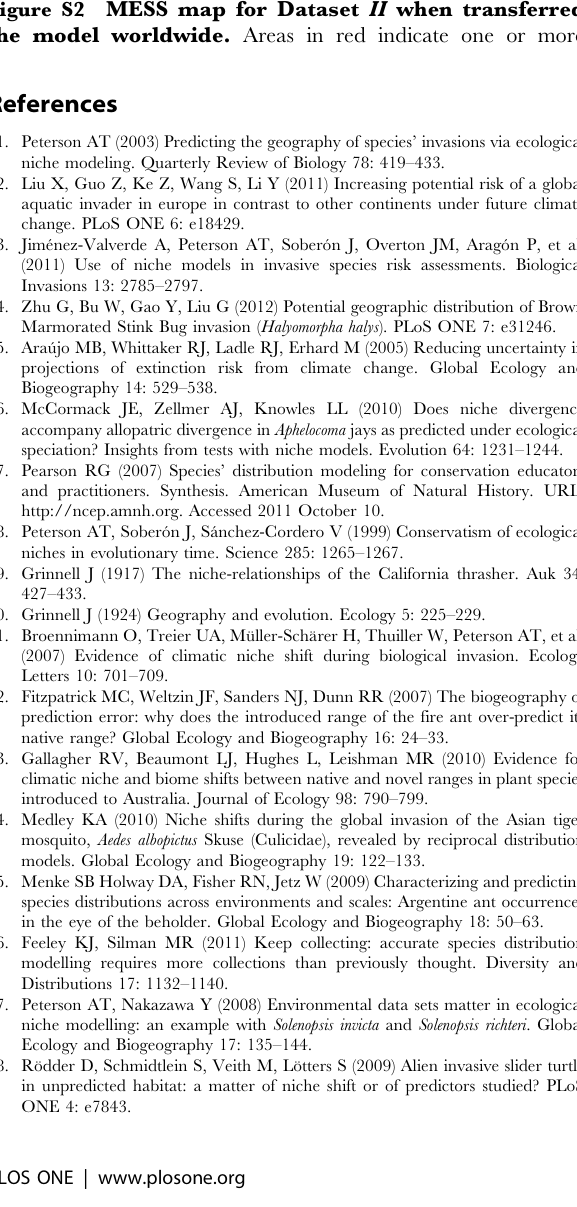
environmental variables outside the range present in the training data. (TIF) Figure S3 Niche models based on Dataset II and transferred worldwide using GARP. Dark green color represents high suitability, light green indicates low suitability. (TIF) Text S1 GARP protocol in exploring area of potential invasion.